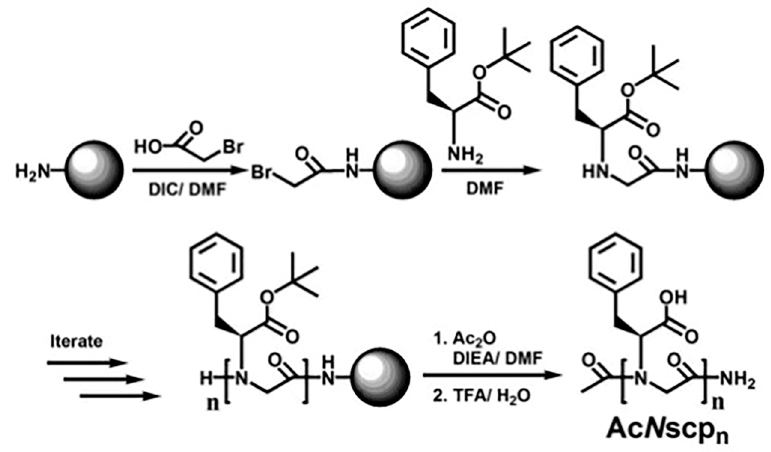
Figure 9. Solid-phase submonomer synthesis of AcNscpn. Reprinted with permission from [87]. Copyright 2007, American Chemical Society.